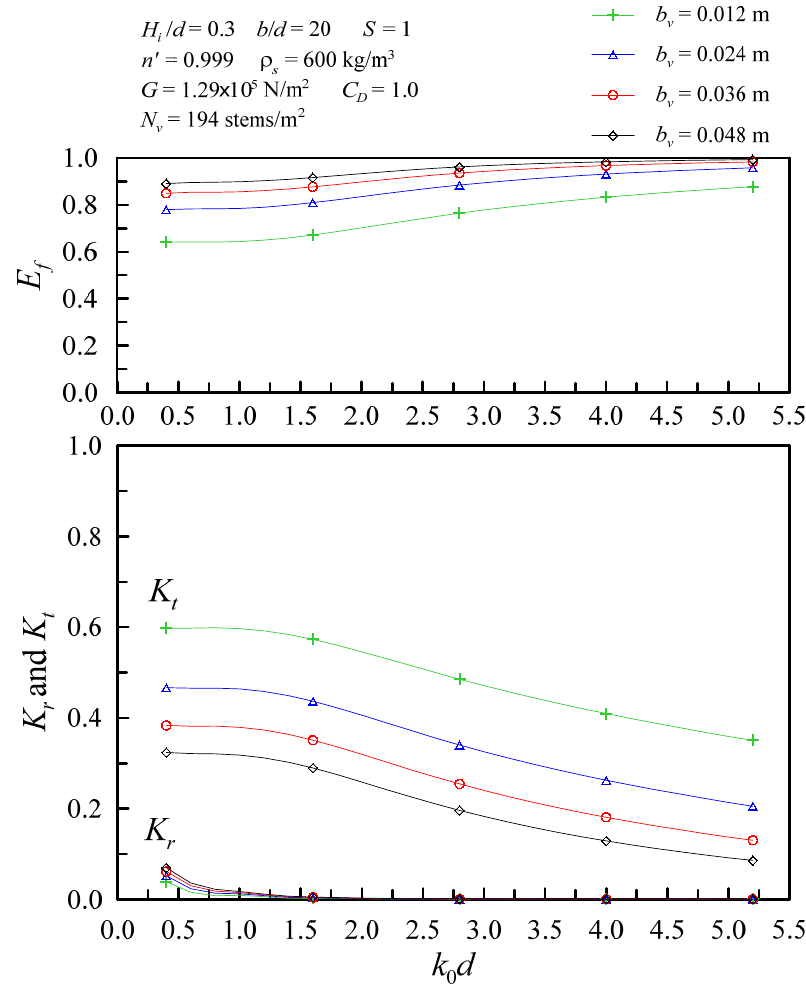
b of vegetation on Figure 7. E ff ect of the plant stem diameter b v of vegetation on K r , K t , and E = 0.3, d = 0.3 m, f ( H i / d v